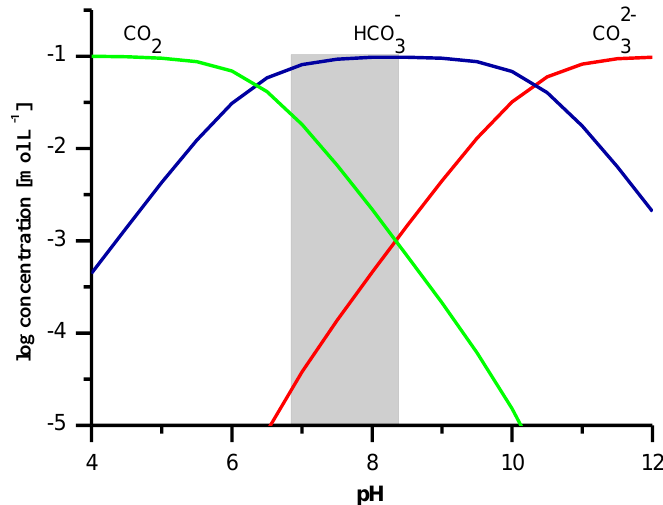
Figure 2. Forms of CO 2 as a function of pH; total concentration of CO 2 0.1 mol L − 1 ; temperature 25 ◦ Figure. 2 . Forms of CO 2 as a function of pH; total concentration of CO 2 0.1 mol L −1 ; temperature 25°C.